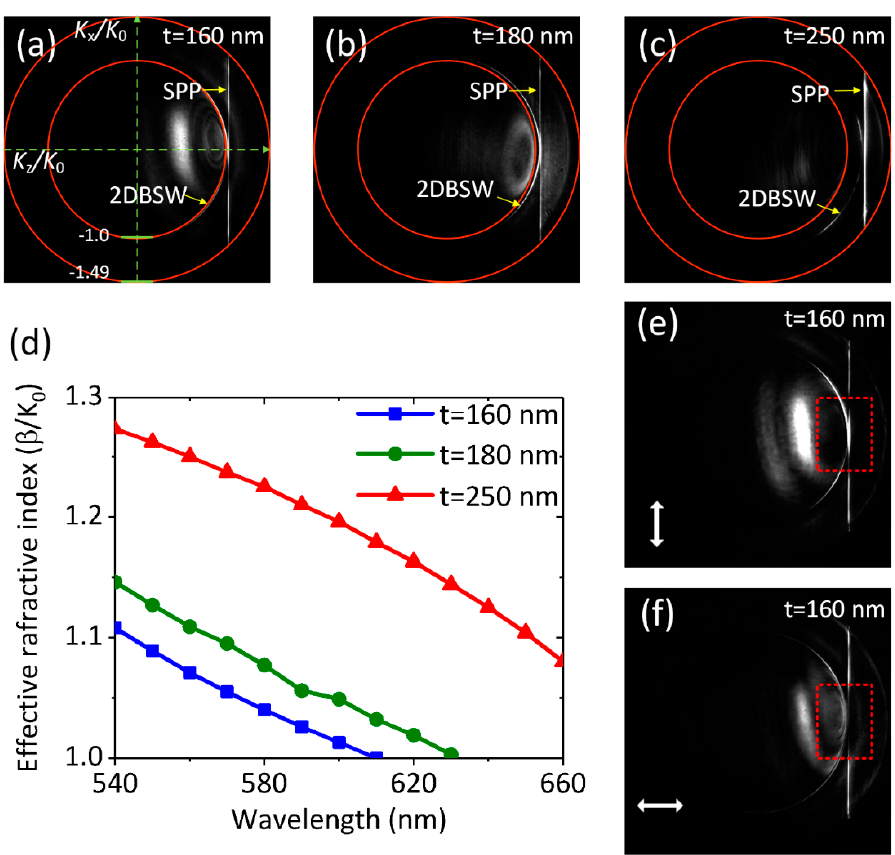
Figure 2. Controlling the effective refractive index of the surface plasmon polariton (SPP) waveguide mode with the top dielectric (SiO 2 ) layer’s thickness. The thickness was selected as t = 160, 180, and 250 nm, respectively. The incident wavelength was selected as 590 nm. ( a – c ) the corresponding BFP images; ( d ) the curves of effective refractive index vs. the incident wavelength in the case of three top layer thicknesses; ( e , f ) BFP images in the case of t = 160 nm with a polarizer before the detector. The white double arrowhead lines represent the direction of the polarizer. On ( a – c ), the red rings with diameters at 1.49 and 1 are given by the numerical aperture (NA) of the objective and the critical angle, respectively.